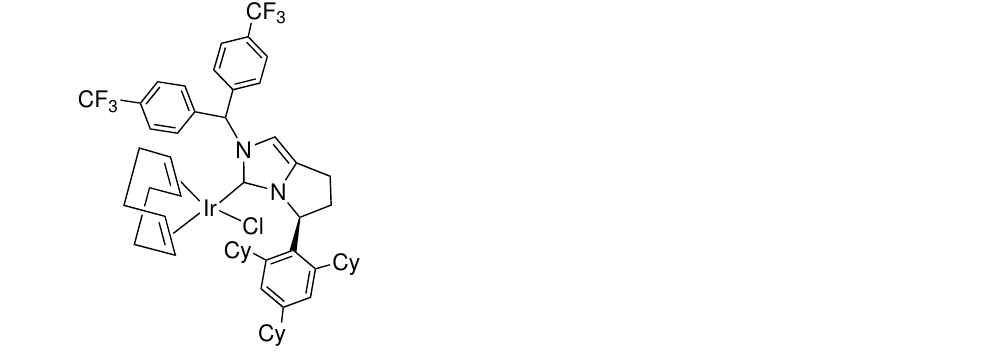
Figure 3. Highly enantioselective iridium NHC catalyst for ATH of ketones designed by Yoshida.